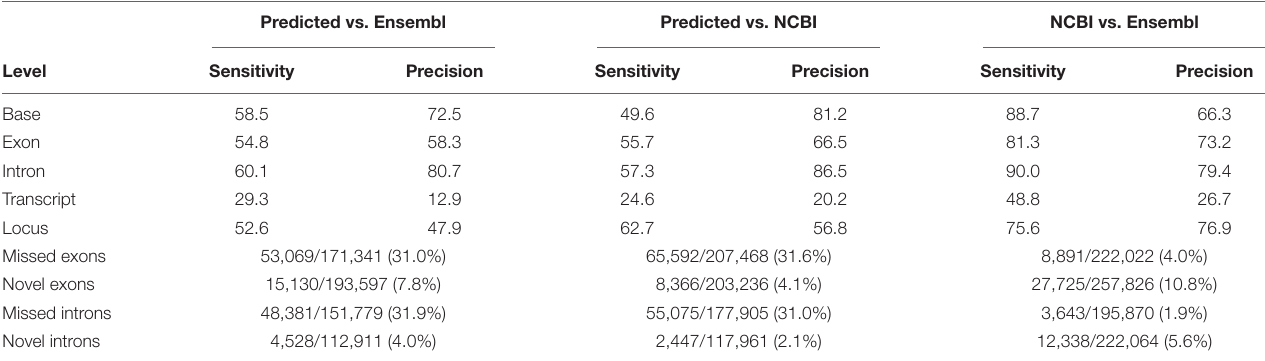
Comparison excludes reference loci without predicted transcripts and predicted transcripts at novel